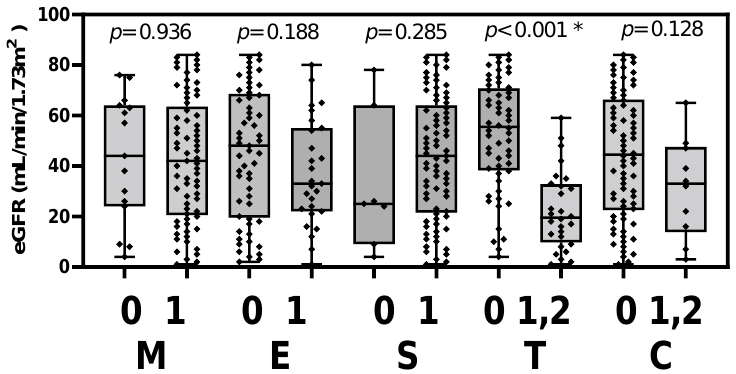
Figure 1. eGFR in the Oxford classification MEST-C score-stratified groups. Levels of eGFR were significantly decreased in IgAN patients with tubular atrophy/interstitial fibrosis ( p < 0.001). eGFR, estimated glomerular filtration rate; M, mesangial hypercellularity; E, endocapillary hypercellularity; S, segmental glomerulosclerosis; T, tubular atrophy/interstitial fibrosis; C, cellular or fibrocellular crescents. * p < 0.05.